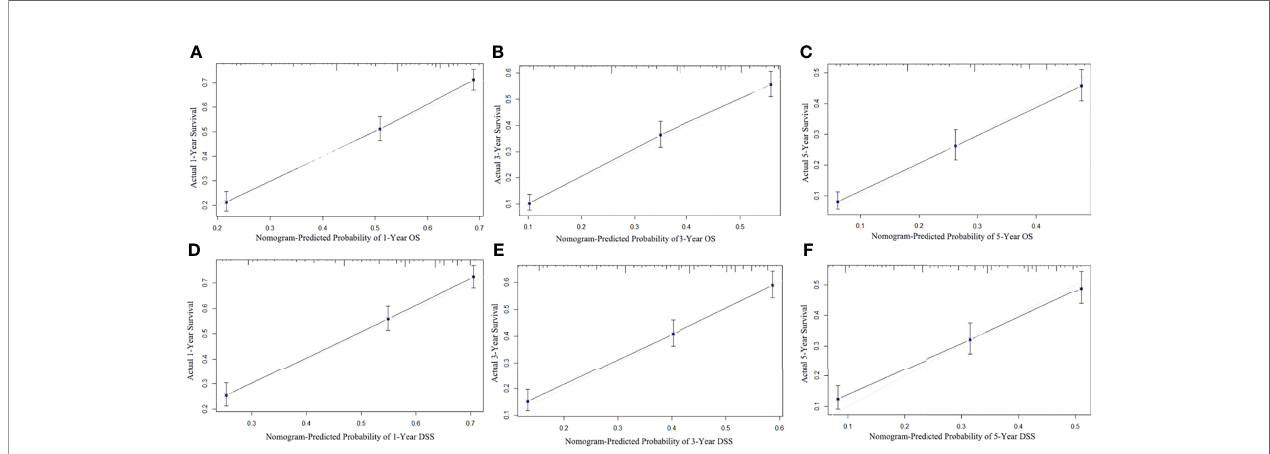
FIGURE 6 | Calibration curve of the nomogram for the prediction of 1-, 3-, and 5-year OS (A – C) and DSS (D – F) . The abscissa represents the nomogram-predicted survival rate, the ordinate represents the actual survival rate, and the calibration curves for 1-, 3-, and 5-year survival rates showed satisfactory agreements between the predicted and actual values.